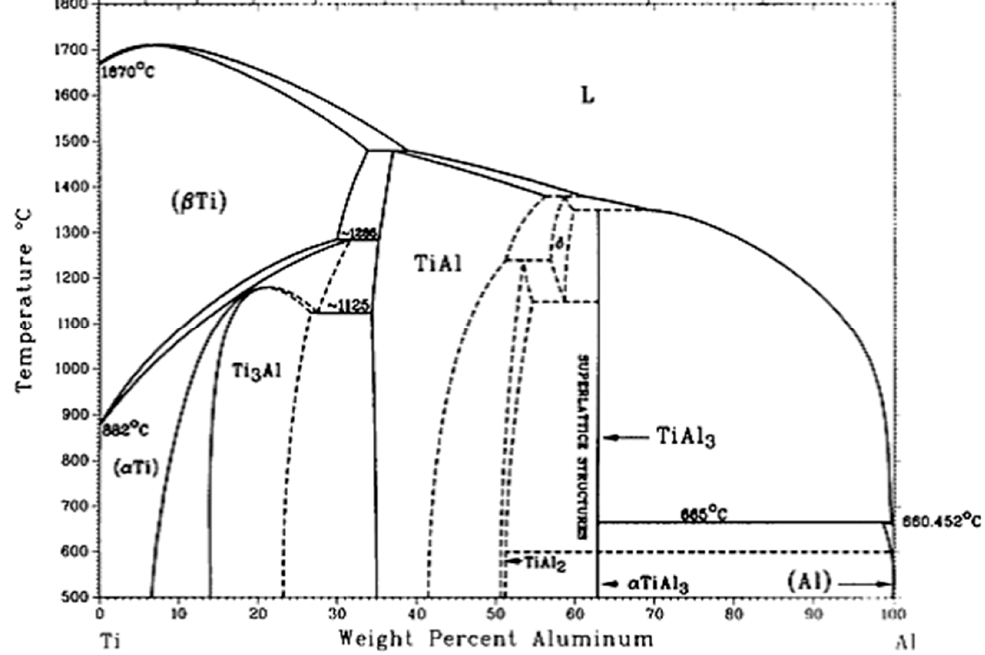
Figure 3. The Al–Ti phase diagram [17].